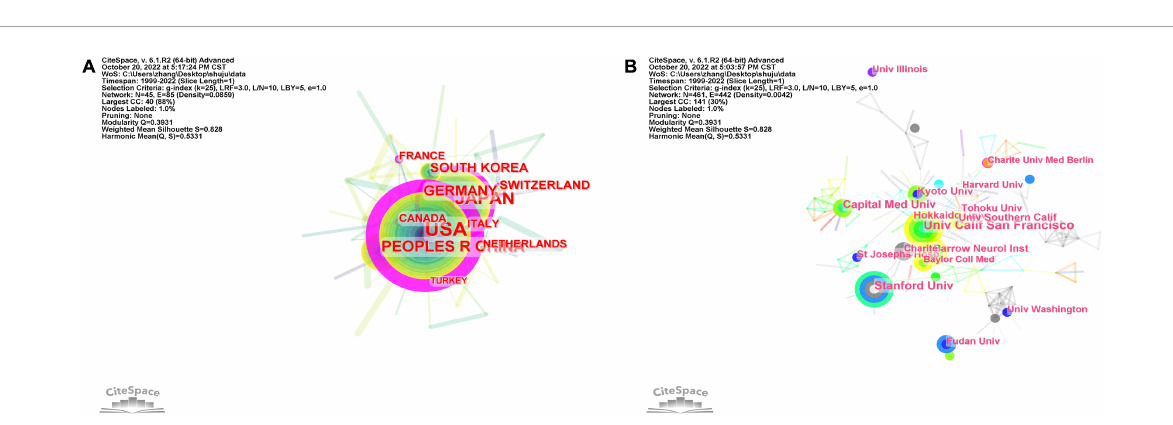
FIGURE3 Analysis of countries and institutions. (A) Visual map of national collaboration based on CiteSpace software. (B) Visual map of institutions based on CiteSpace software. Each node represents a country/institution, and each connecting line represents the central cooperativeness between countries/institutions. The thicker the line, the closer the cooperation between countries/institutions.